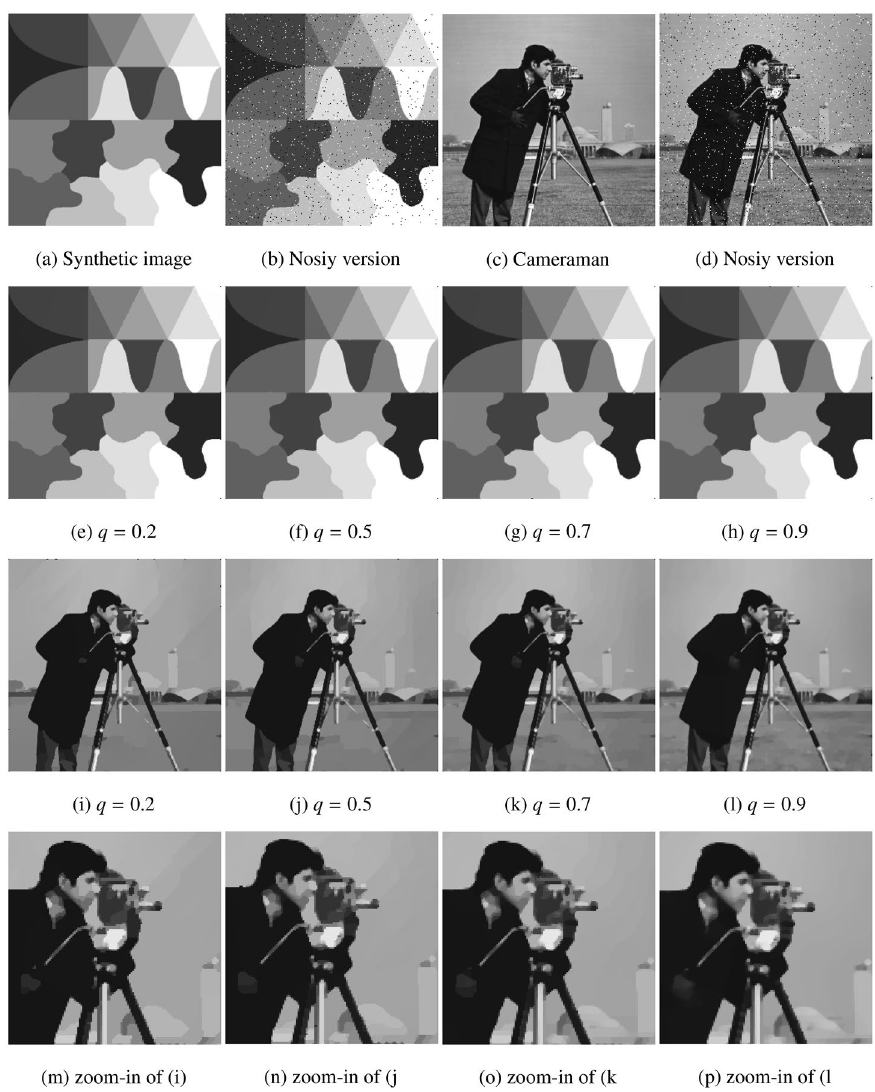
Figure 5. The test of l q -norm nonconvex penalty functions with different q -values.